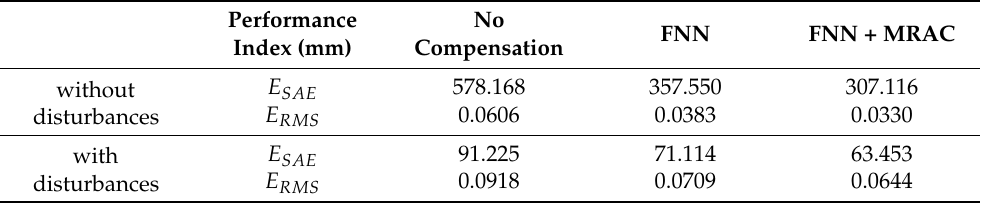
Table 3. Synchronous performance under low-frequency commands.